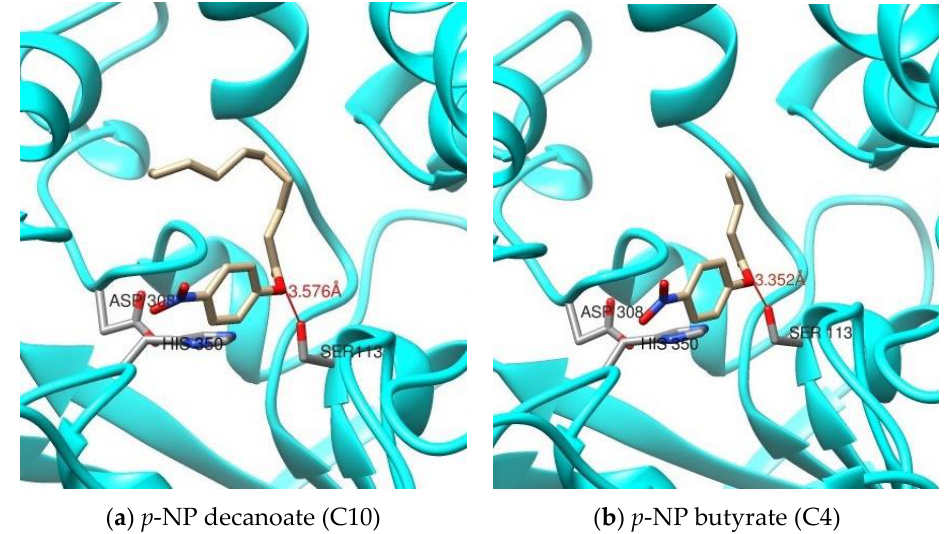
Figure 9. The binding mode of the complexes between rHZ lipase and p -NP decanoate (C10) ( a )and p -NP butyrate (C4) ( b ). The catalytic residues contained Ser113, Asp308, and His350.